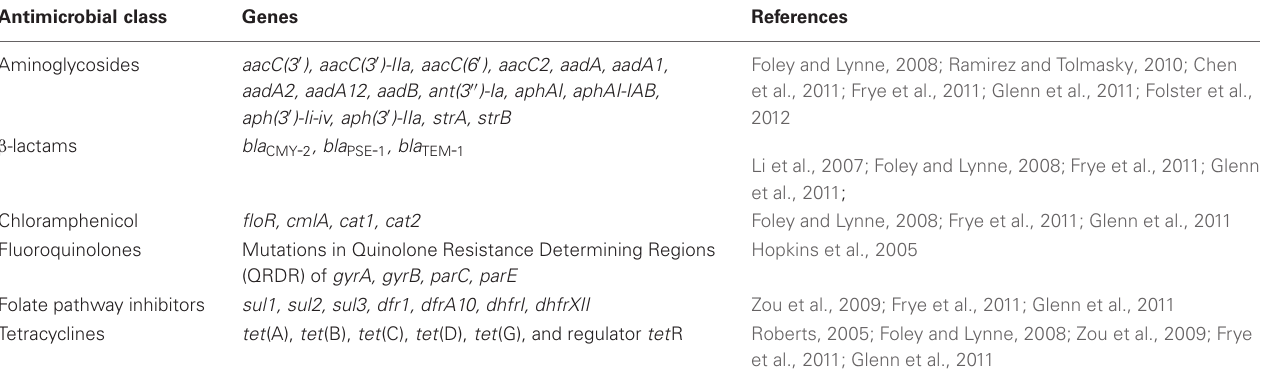
Table 2 | Antimicrobial resistance genes found in Salmonella enterica isolated from U.S. food